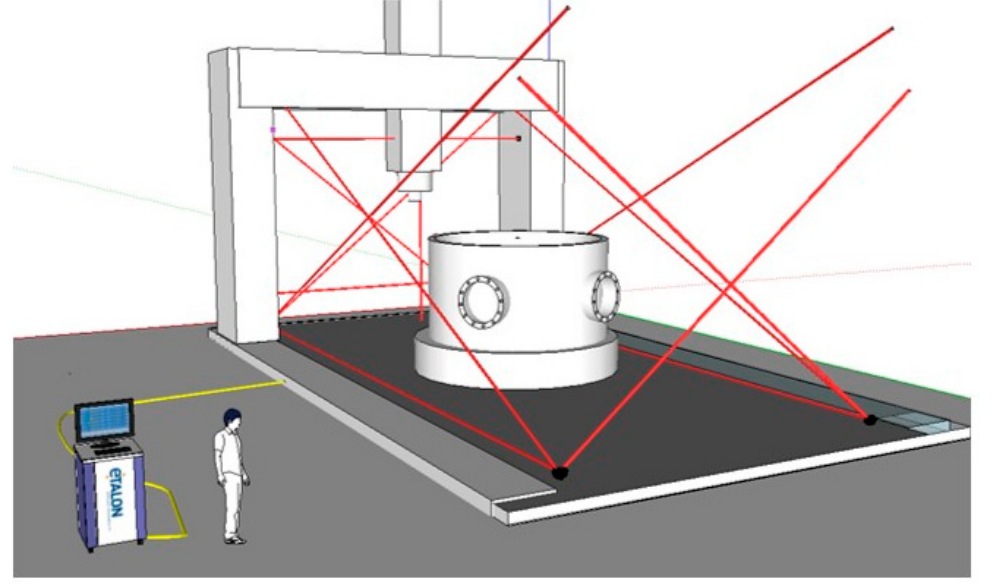
Figure 11. Multiline example on a large MT [125].